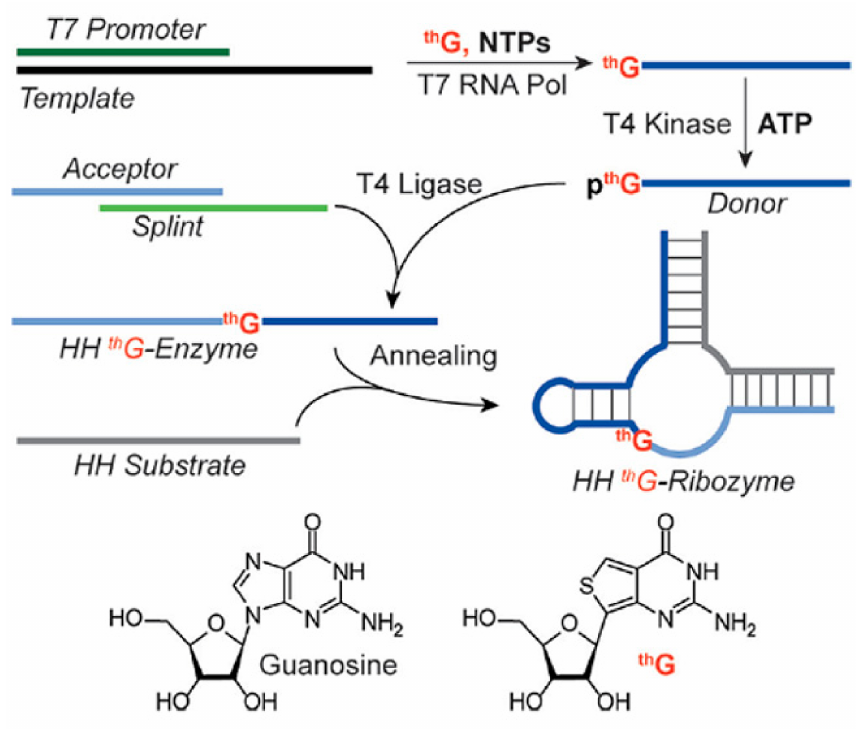
Figure 8. Formation of RNAs site-specifically labeled with th G. Reprinted with permission from reference